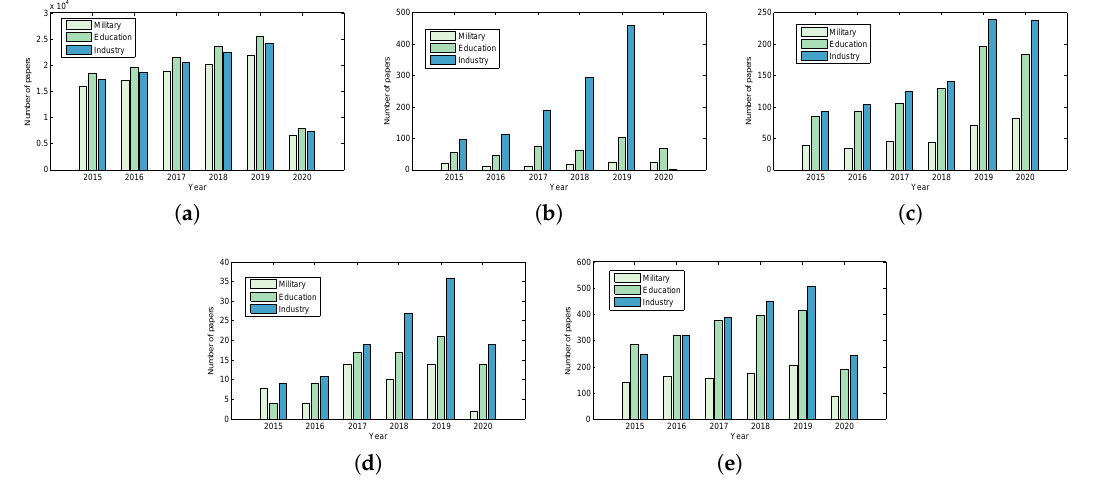
Figure 3. ( a ) CRs in ACM ( b ) CRs in ScienceDirect ( c ) CRs in Springer ( d ) CRs in IEEE ( e ) CRs in